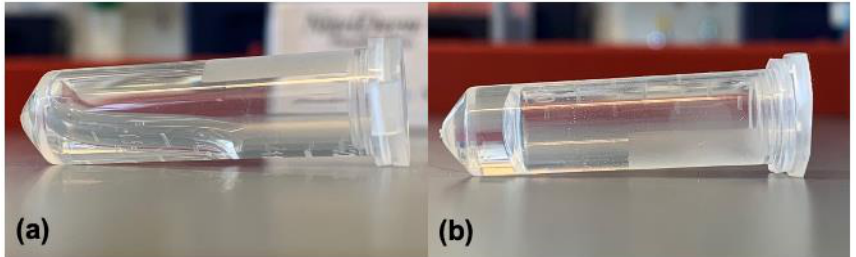
Figure 2. Representative photos of the blank hydrogel mixture at room temperature ( a ) and after incubation at 37 °C ( b ).